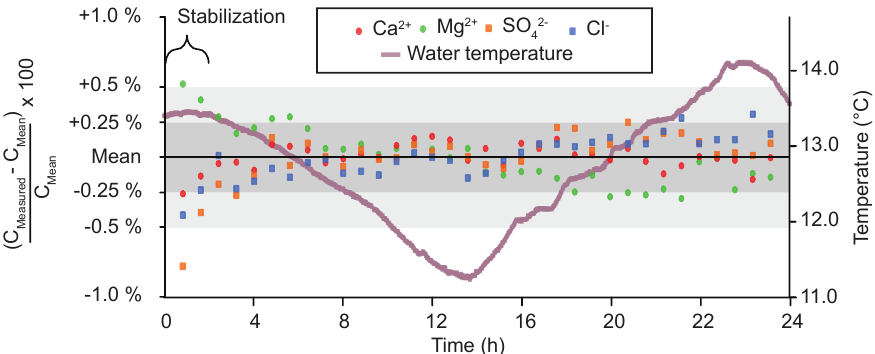
Figure 2. Assessment of the precision (in deviation from the mean for four dissolved species) of the whole RL system including the primary circuit, filtration systems and IC instruments (17 April 2016). A closed system is established on the primary circuit of the RL by connecting the inlet and the outlet through a 300L tank of river water. The system is then run for a period of 24h. The time between two IC analyses is 40min. The purple curve represents data of temperature of the water in the tank. We do not consider the first 2h (three first measurements), corresponding to the homogenization of water in the circuit and tank (see conductivity measurements in Fig. S2) for the calculation of precision.